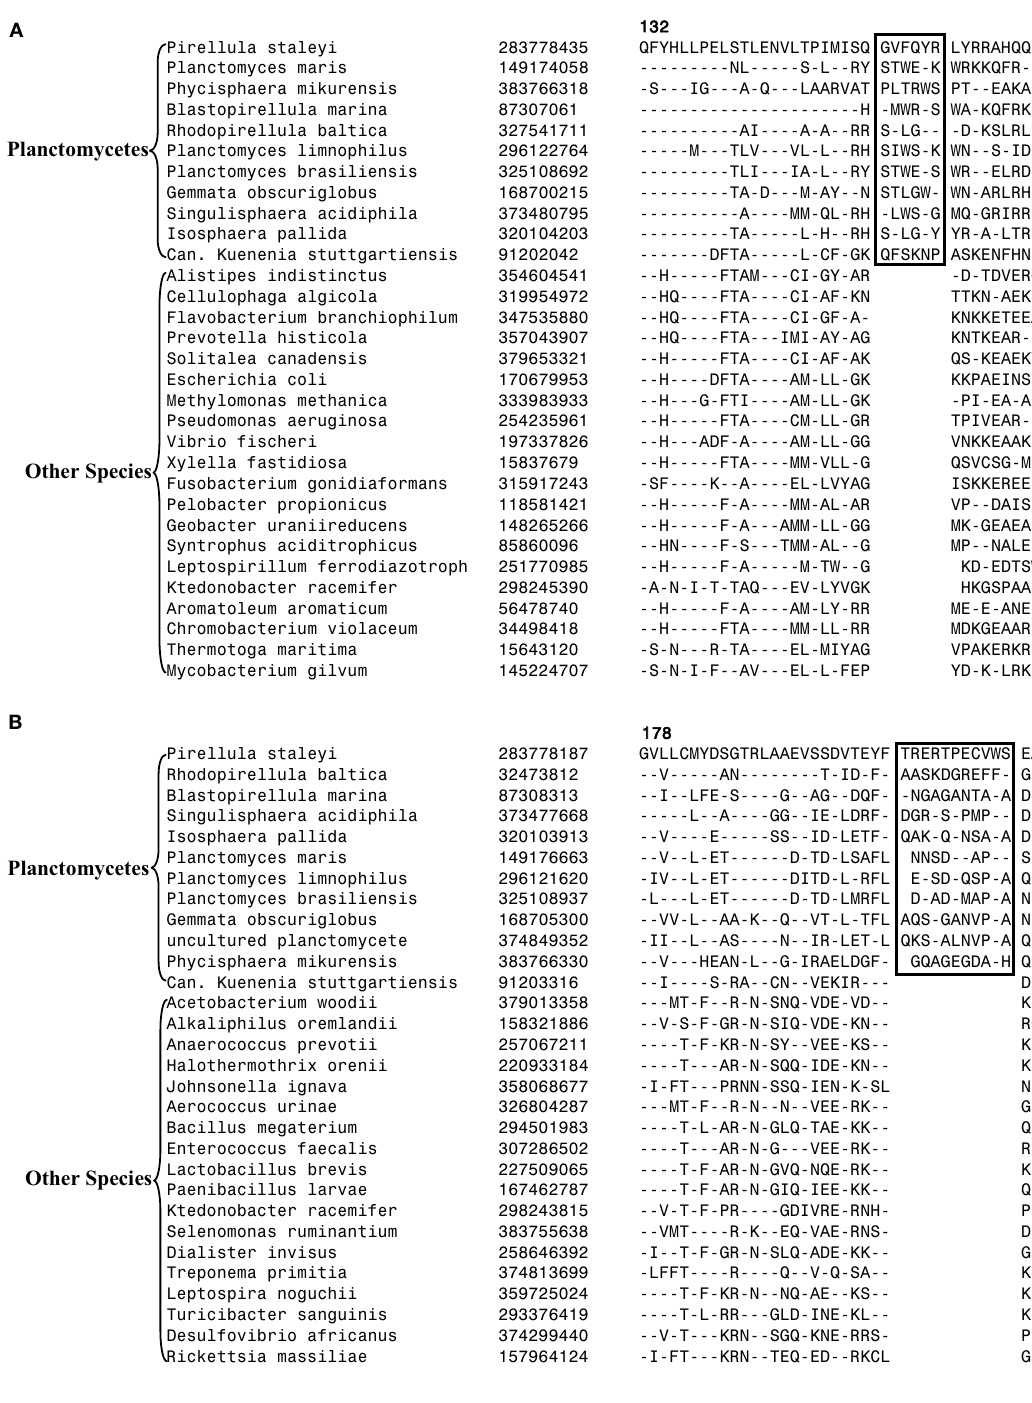
11 aa insert in the cobyrinic acid ac-diamide synthase that is specific for all sequenced Planctomycetes except Candidatus Kuenenia stuttgartiensis